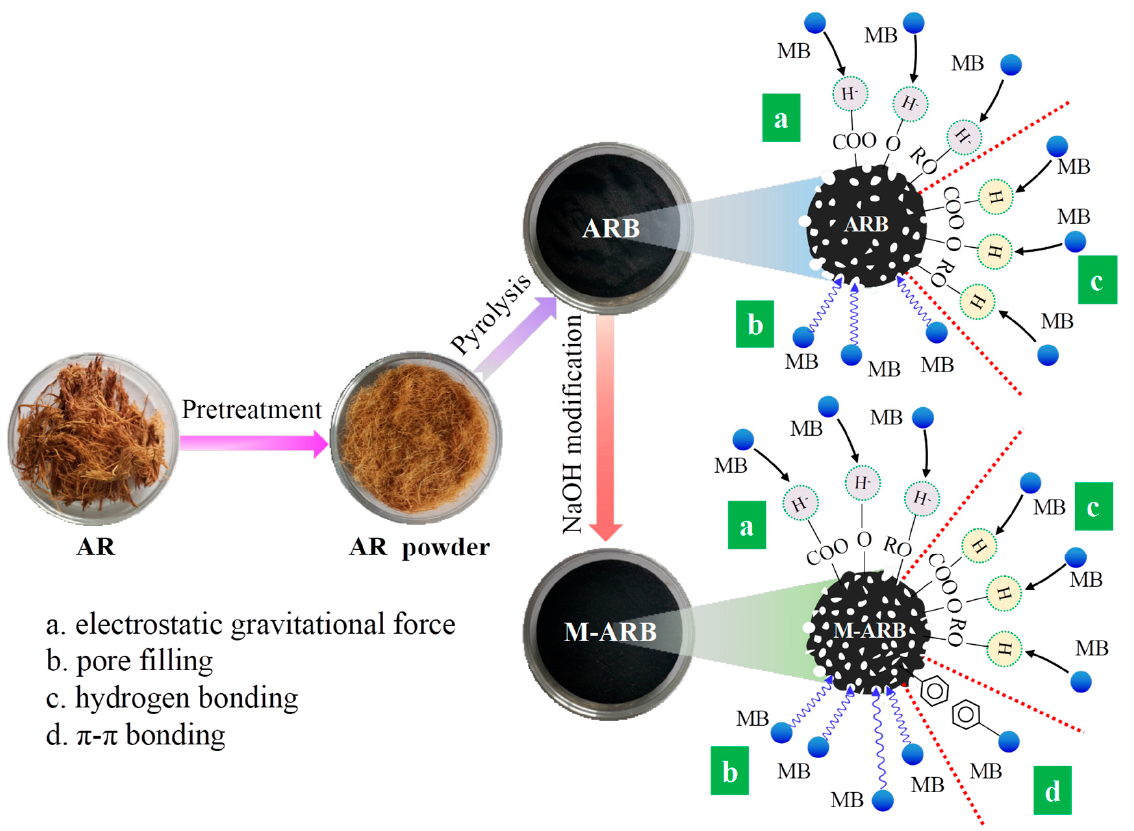
Figure 12. Adsorption mechanism of ARB and M-ARB for MB.